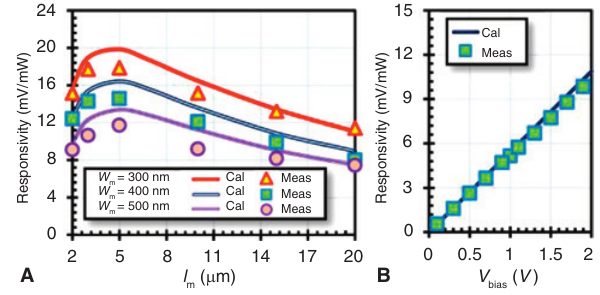
Figure 4: The responsivities. (A) Measured and calculated responsivities of the power monitors = 2 V as the metal-strip length l operating at V bias = 300, 400, and 500 nm). (B) Responsivity of the power monitor w m = 400 nm and l = 15 μ m as the bias voltage V with w m m = 1 the input optical power is P in